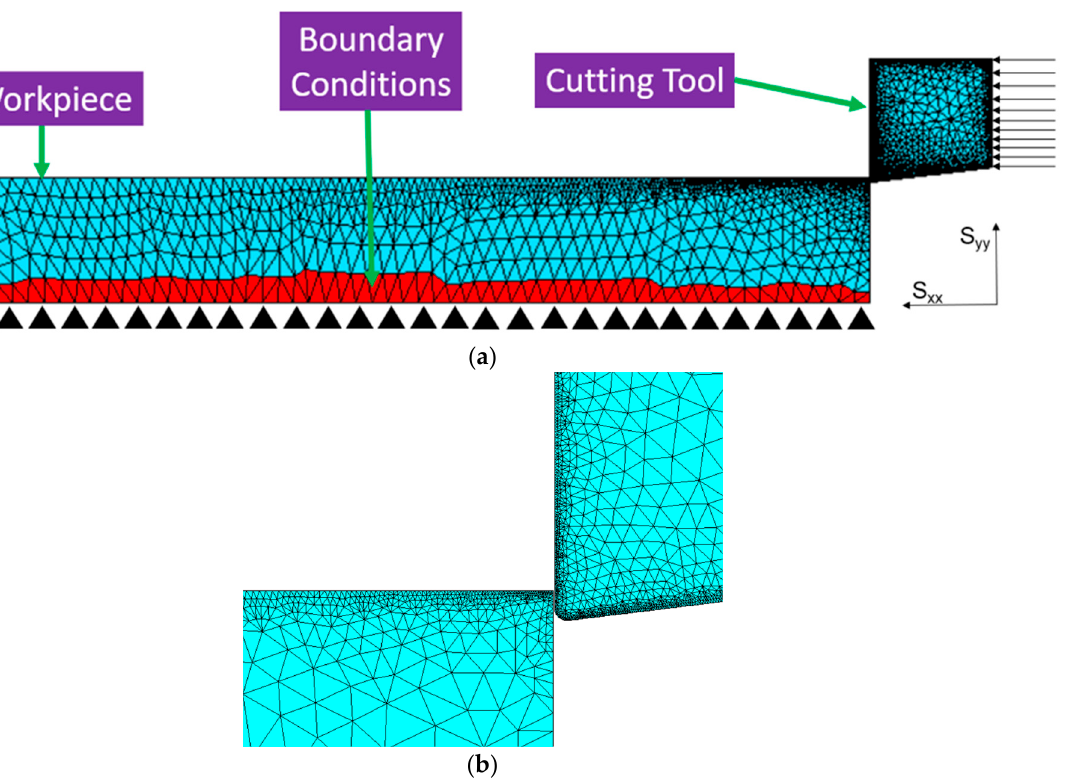
Figure 1. ( a ) Boundary conditions and meshing employed for workpiece and machining tool used in numerical prediction model for AdvantEdge TM. ; ( b ) Zoomed in version of tool and workpiece.